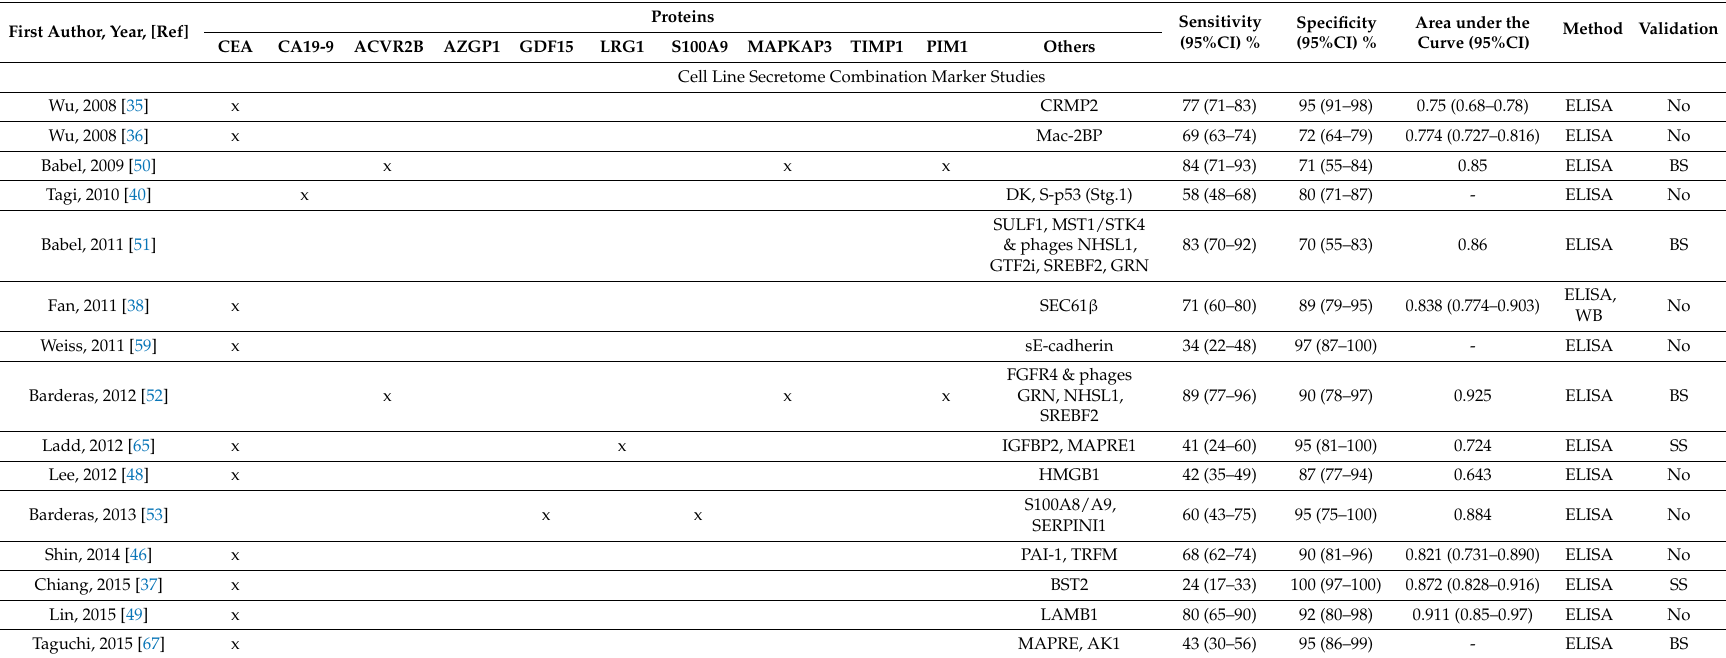
Table 3. Diagnostic performance of cell line secretome markers validated in